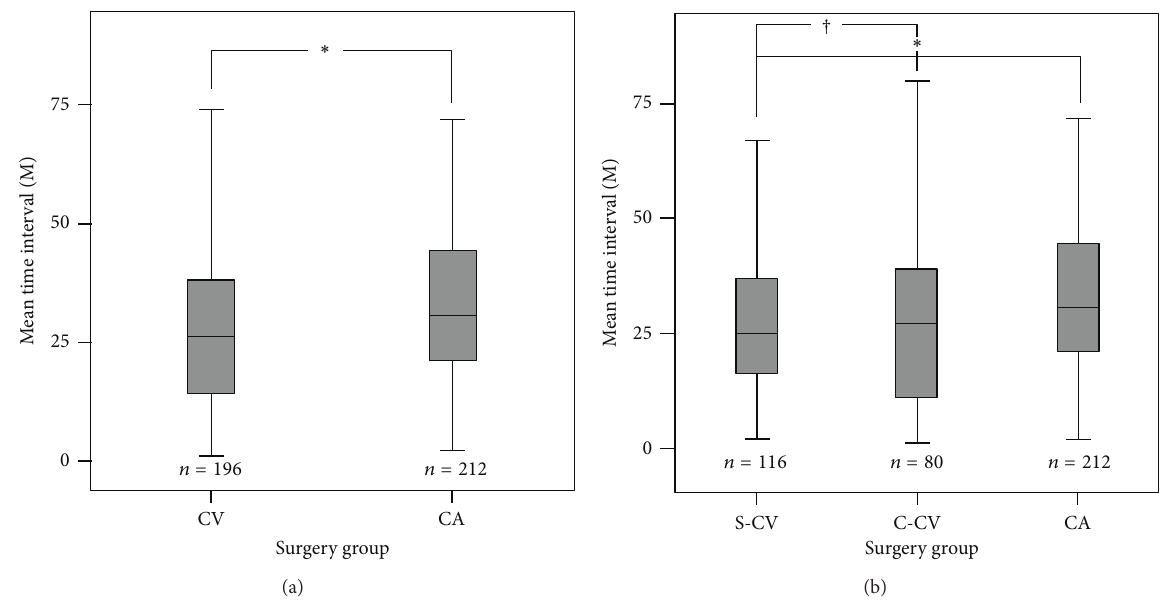
Figure 1: Comparisons of mean time interval from cataract surgery to Nd:YAG capsulotomy in each group (gray bars). The CV group had a shorter time interval than the CA group ((a), 𝑃 = 0.006 ). The S-CV and C-CV groups had shorter time intervals than the CA group, ((b), 𝑃 = 0.013 and 0.043, resp.). There was no difference between the S-CV and C-CV groups ( 𝑃 = 0.321 ). The asterisk indicates a statistically significant difference in the mean time interval. A cross indicates no difference between S-CV and C-CV groups.